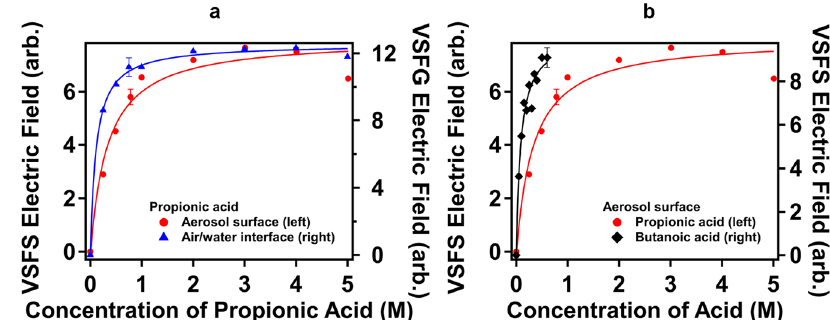
Fig. 4 Concentration dependent adsorption to curved and planar surfaces. a Vibrational sum frequency scattering (VSFS) electric fi elds of CH 3 -as for aerosol curved surfaces (red solid circle, right axis) and VSFG electric fi elds of CH 3 -as for the air/water planar interface (blue solid triangle, right axis) as a function of propionic acid concentration in a 0.5 M NaCl seed solution. b VSFS electric fi elds of – CH 3 -as as a function of butanoic acid concentration in 0.5 M NaCl seed solution (black sold diamond, right axis), in comparison with those for propionic acid (red solid circle, left axis). Error bars represent